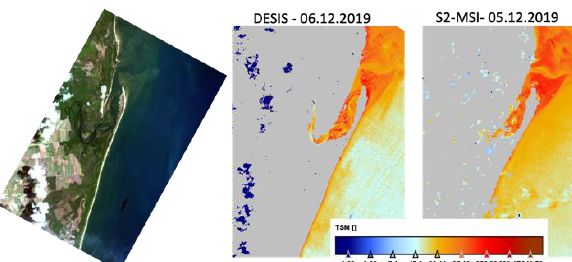
Figure 8 . True colour composite of DESIS Level 1B (left) and the retrieved total suspended matter (mg/L) with Polymer at the Lucinda AERONET-OC study region. Grey and white regions are masked as in Figure 3.